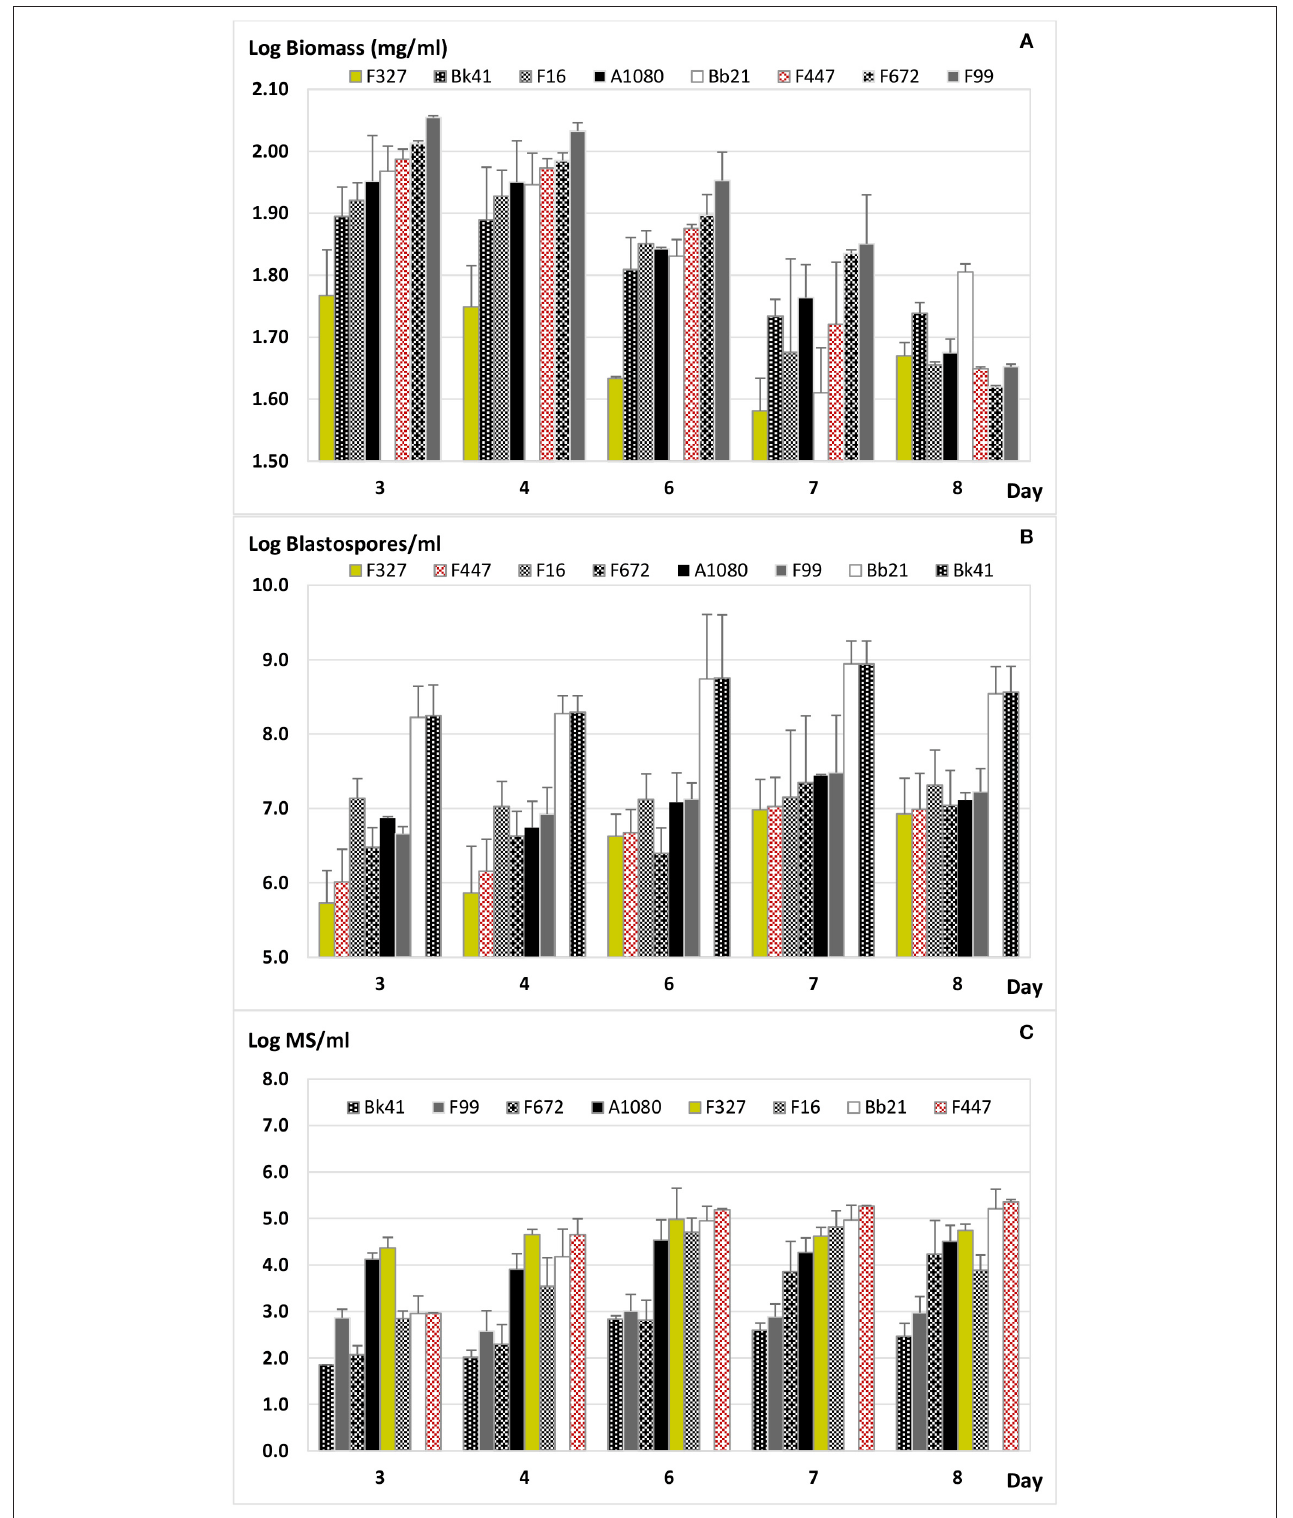
FIGURE 1 | Fungal growth in liquid fermentation in basal salts solution with trace metals and vitamins (C:N ratio 23:1). (A) Fungal biomass (dry weight Log 10 mg/mL); LSD 5 % = 0.075, p < 0.01. (B) Blastospore production (Log 10 number/mL); LSD 5 % = 0.557, p = 0.288. (C) Microsclerotia production (Log 10 number/mL); LSD 5 % = 0.498, p < 0.01. Error bars = standard error.